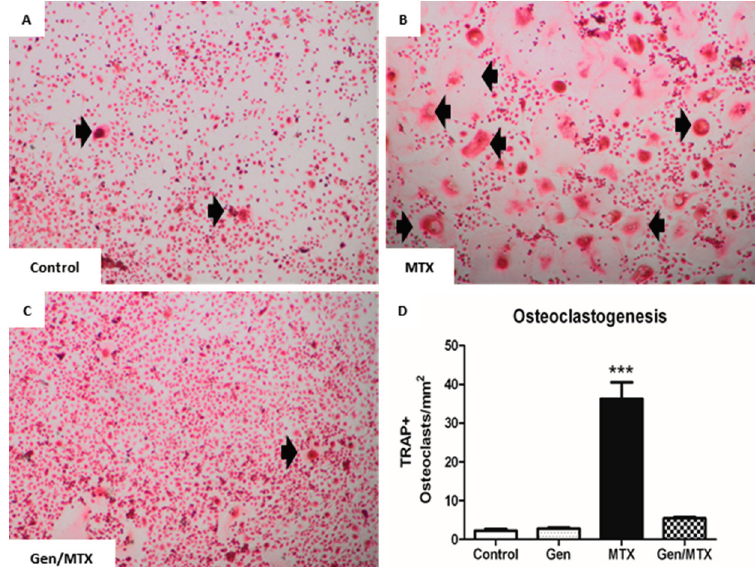
Figure 4. Co-treatment with genistein (Gen) significantly suppressed MTX-induced ex vivo osteoclast formation. ( A – C ) Representative images (20×) of osteoclasts differentiated in the presence of macrophage colony stimulating factor (M-CSF) and receptor activator of NF- κ B ligand (RANKL) from bone marrow mononuclear cells isolated from control, MTX-, and Gen + MTX-treated rats, respectively. Cells were subsequently stained with TRAP to identify osteoclasts; ( D ) Osteoclasts were identified as large, TRAP + , and multinucleated cells ( ≥ 3 nuclei) (black arrows in panels A – C ) and quantified as osteoclasts/mm 2 of culture dish. n = 6, *** p < 0.001 vs.